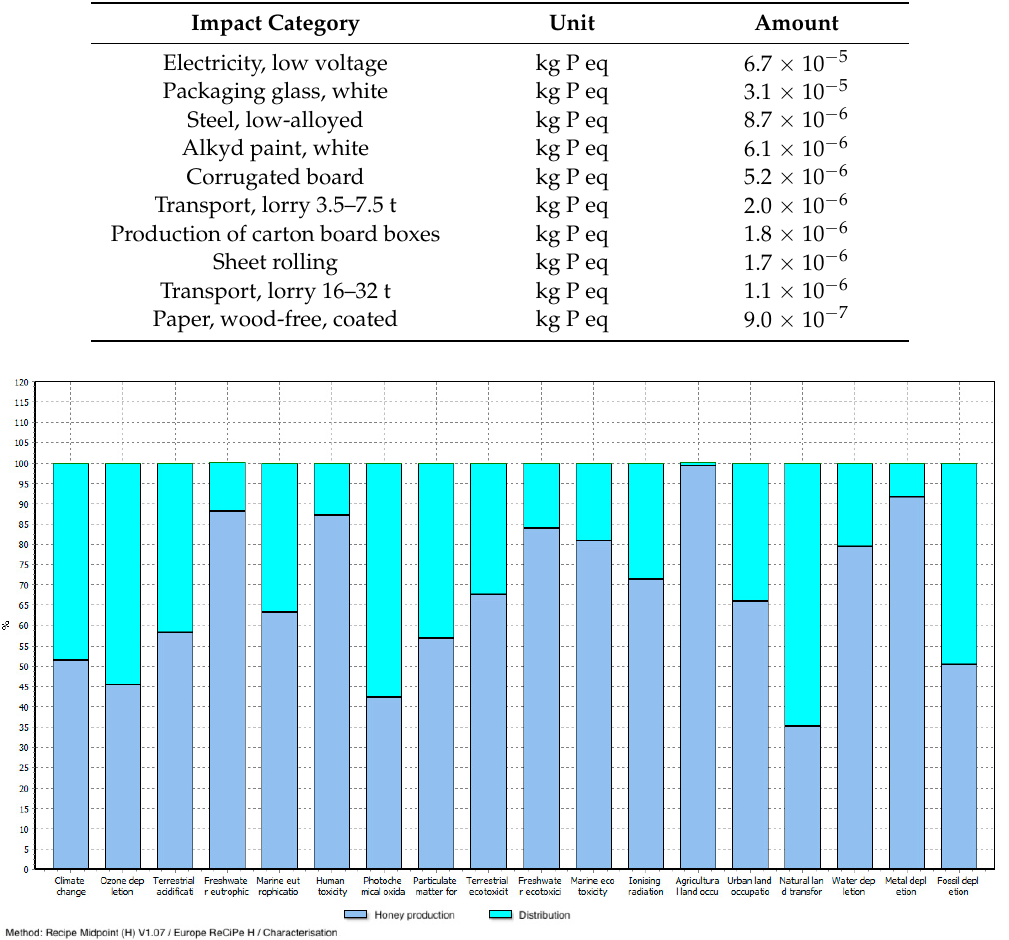
Characterisation results for freshwater eutrophication—first ten processes (30% assumption—from SimaPro (Pr é 2018)).